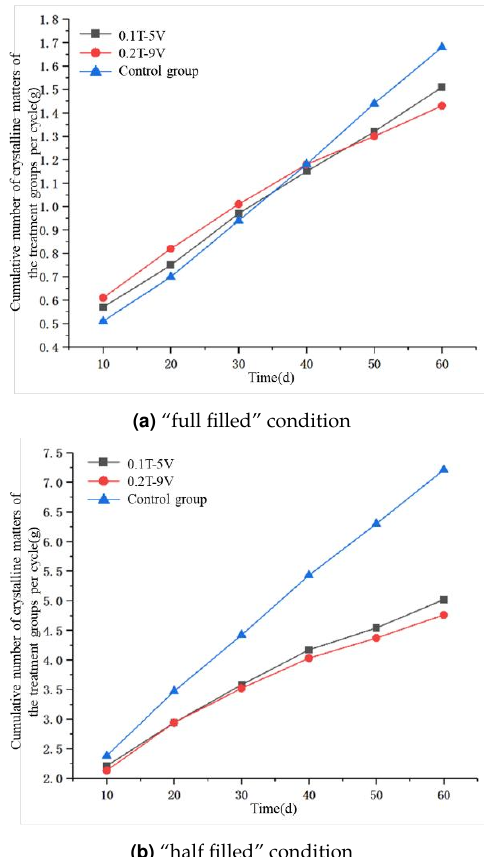
Fig. 12. Changes of the number of cumulative crystalline matters of the treatment groups under the water filling condition over